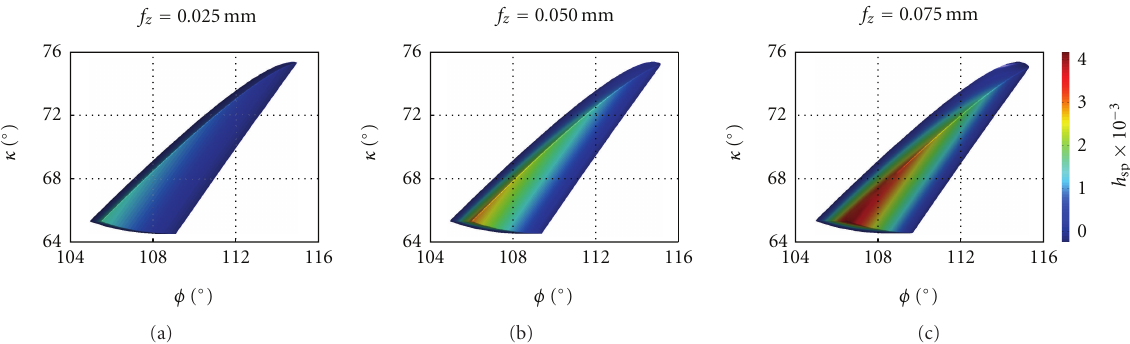
Figure 9: Influence of the feed-rate on the contact diagram.